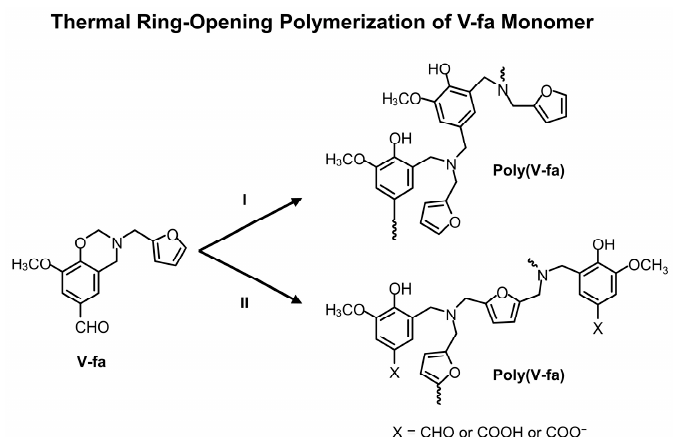
Figure 3. Chemical structures of V-fa monomer and the network structures of poly(V-fa) following ring-opening polymerization.